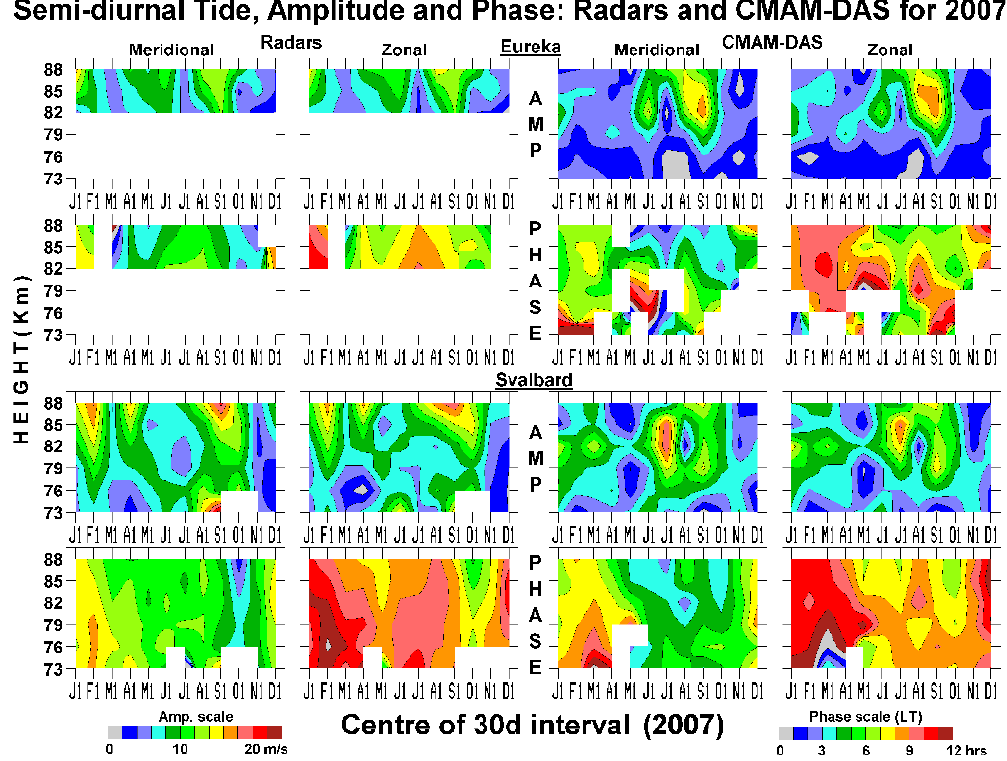
Fig. 8. Zonal ( U , EW) and meridional ( V , NS) winds for the semidiurnal (12-h) tides (SDT) above Eureka and Svalbard for year 2007 from the two MWR and CMAM-DAS, and from the harmonic fits to the mean wind, 24- and 12-h tidal amplitudes and phases: the phases are the local solar times of maximum northward and eastward